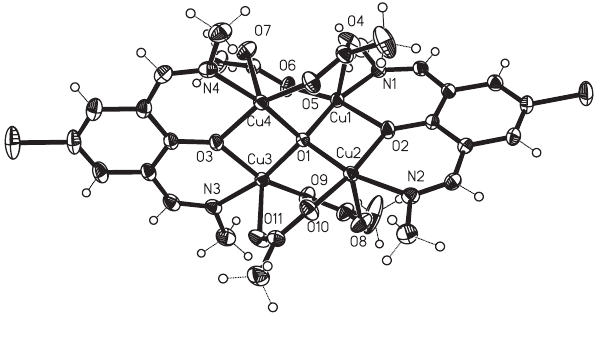
Table 1: Data collection and